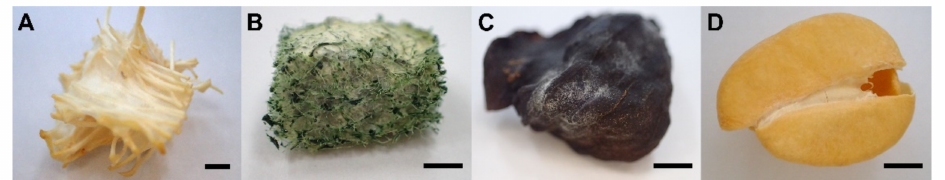
Figure 2. Immobilisation of Trametes hirsuta PW17-41 on different solid supports: ( A ) nylon sponge; ( B ) loofah; ( C ) cascara coffee; ( D ) parchment coffee. Bars = 0.1